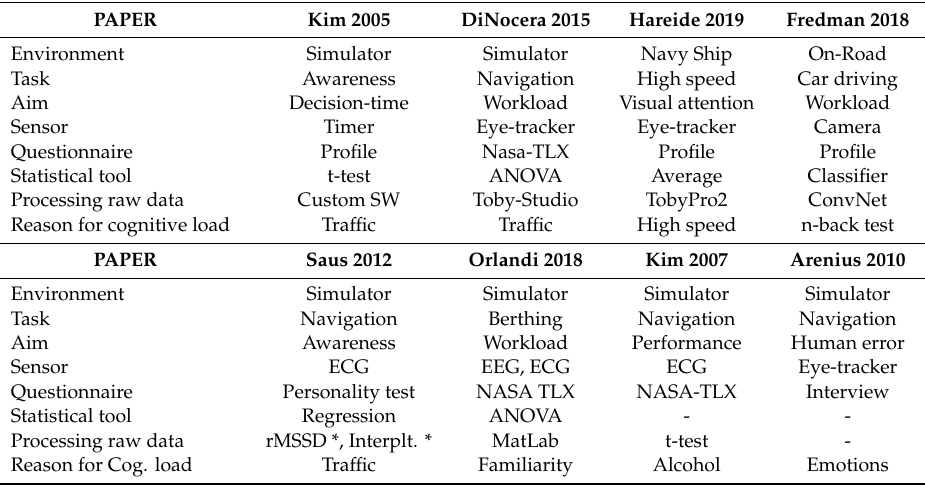
Table 3. Indirect approach of cognitive load